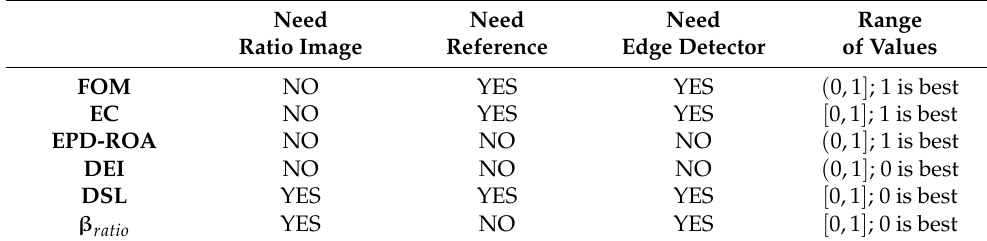
Table 1. A list of some classical EDGE-preservation